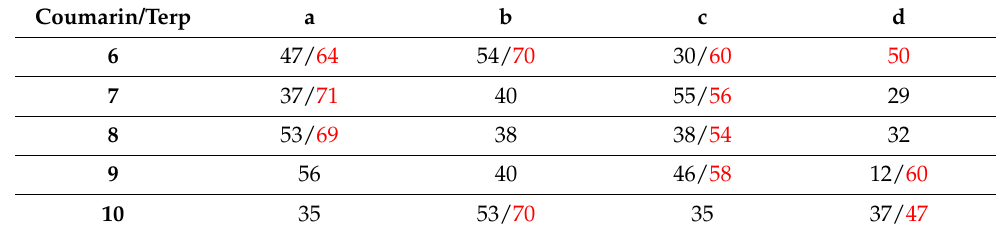
Table 1. Yields of compounds 6–10 (%), obtained by methods A (black color) or B (red color). Table 1 . Yields of compounds 6 – 10 (%), obtained by methods A (black color) or B (red color) . Coumarin/Terp a b c d Coumarin/Terp a 6 47/64 54/70